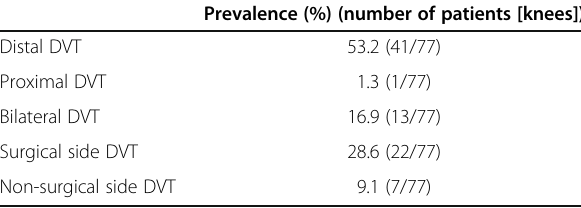
Table 3 The prevalence of postoperative DVT in TKA patients Prevalence (%) (number of patients [knees]) Distal DVT 53.2 (41/77) Proximal DVT Bilateral